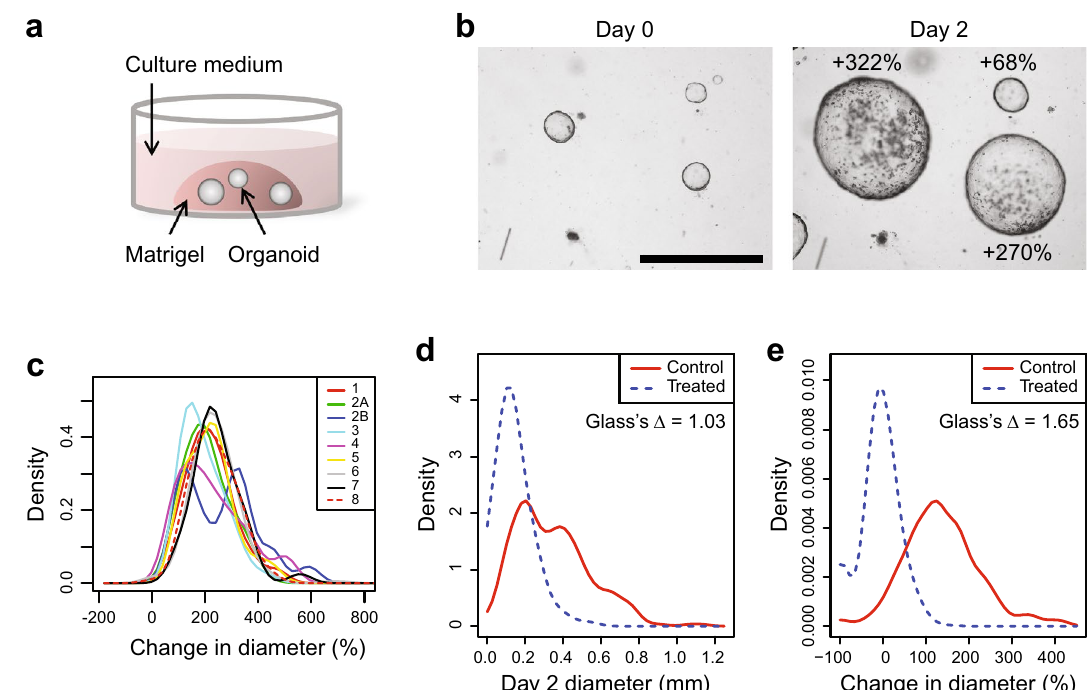
Figure 1. Mouse derived cancer organoids grow heterogeneously within a culture. ( a ) Graphic illustrating how MDCOs isolated from Fc 1 Apc fl/ + Pik3ca H1047R mice are cultured within a Matrigel matrix, with feeding media overlayed. For therapeutic studies, overlayed feeding media is replaced with new media containing drug. ( b ) Kernel density plot comparing the growth of MDCOs at the population level derived from 8 different mice of the same genotype. Each line indicates the growth of MDCOs in feeding media derived from one mouse. Note that mouse 2 had two MDCO lines derived from two distinct tumors (line 2A and 2B). ( c ) Representative image of the heterogeneous growth rates of MDCOs within a culture over 48 h. ( d ) Density plot comparing the growth and response of MDCOs using only the final diameter (mm) after 48 h. This analysis represents a well level analysis where MDCOs are only evaluated on the final day of a study. Effect size was calculated using Glass’s delta to compare the treatment group to the control group. ( e ) Kernel density plot comparing the growth and response of MDCOs using their percent change in diameter over the 48-h incubation. This analysis examines the MDCOs on an individual level to determine how individual MDCOs change in diameter over the course of a study. Effect size was calculated using Glass’s delta to compare the treatment group to the control group. The studies used in ( d ) and ( e ) include MDCOs treated with normal feeding media (Control) or copanlisib (200 nmol/L) (Treated) for 48 h. Representative images from ( c ) are shown at the same magnification. Size bar, 1